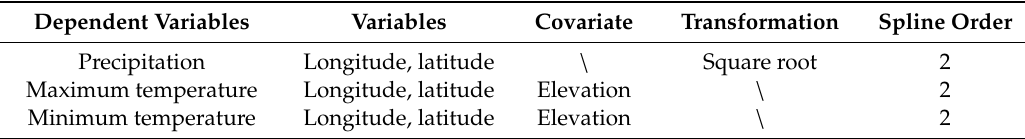
Table 1. The options of the Australian National University spline interpolation (ANUSPLIN) setup for the di ff erent meteorological variables. Dependent Variables Variables Covariate Transformation Spline Order Precipitation Longitude, latitude \ Square root 2 Maximum temperature Longitude, latitude Elevation \ 2 Minimum temperature Longitude, latitude Elevation \ 2 Marks: “ \ ” means no covariate or no